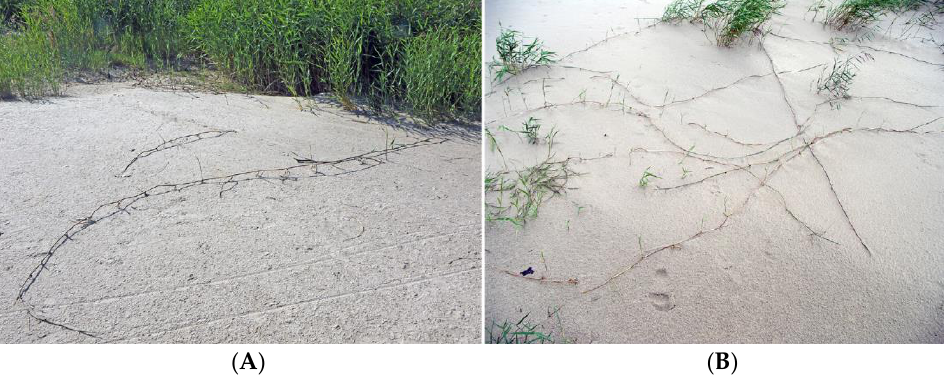
Figure 16. Foraging clonal structures of Phragmites australis on a wet beach in Ainaži, Latvia ( A ) and in Lielupe, Jūrmala, Latvia ( B ).